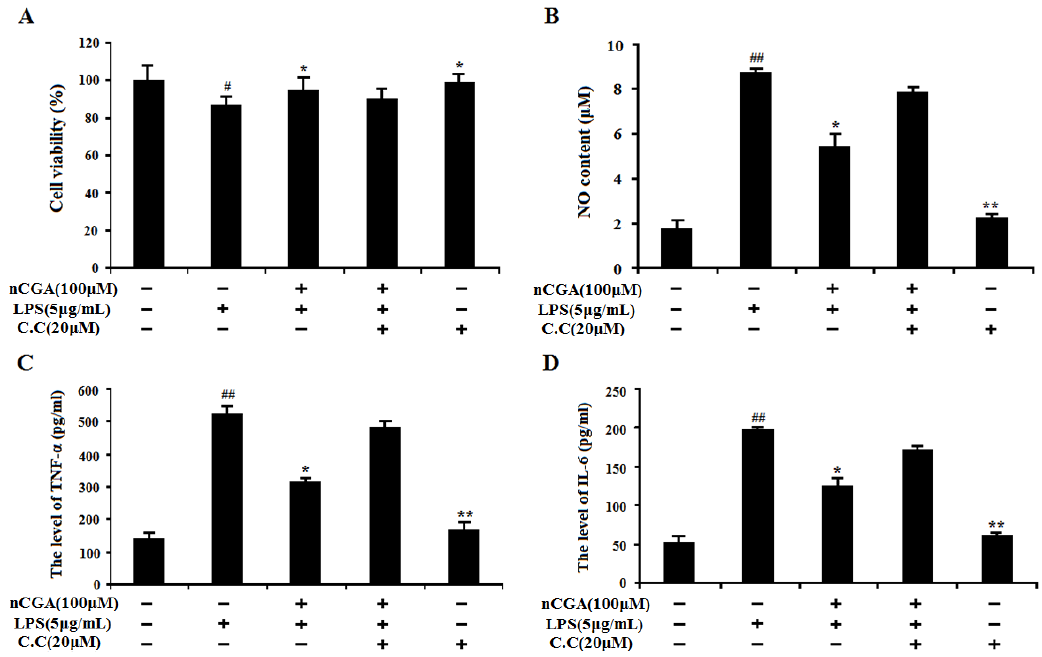
Figure 6. Effect of AMPK activation in the process of nCGA against LPS-induced inflammatory responses. A 549 cells were pre-incubated with presence or absence C.C (20 μ M) for 1 h, and then treated with 100 μ M nCGA for 2 h before exposure with LPS. ( A ) The cell viability was detected by MTT assay. ( B ) NO content. ( C , D ) The levels of TNF- α and IL-6 were measured by ELISA assay. The values represent the mean ± SD of three independent experiments, significant differences between different groups. # p < 0.05, ## p < 0.01 vs. control group, * p < 0.05, ** p < 0.01 vs. LPS alone.